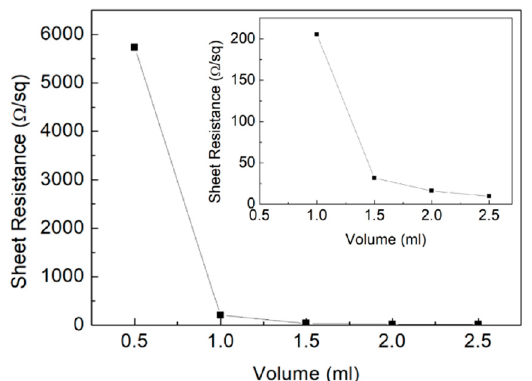
Figure 2. The relationship between sheet resistance of the printed AgNWs patterns and amount of silver nanowires ink. The inserted was a local enlarged image and photo of prepared silver nanowires ink.